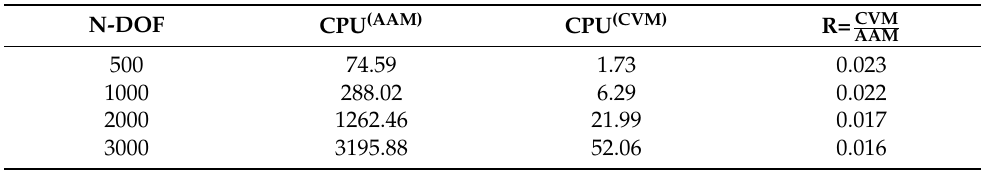
Table 4. Time integration